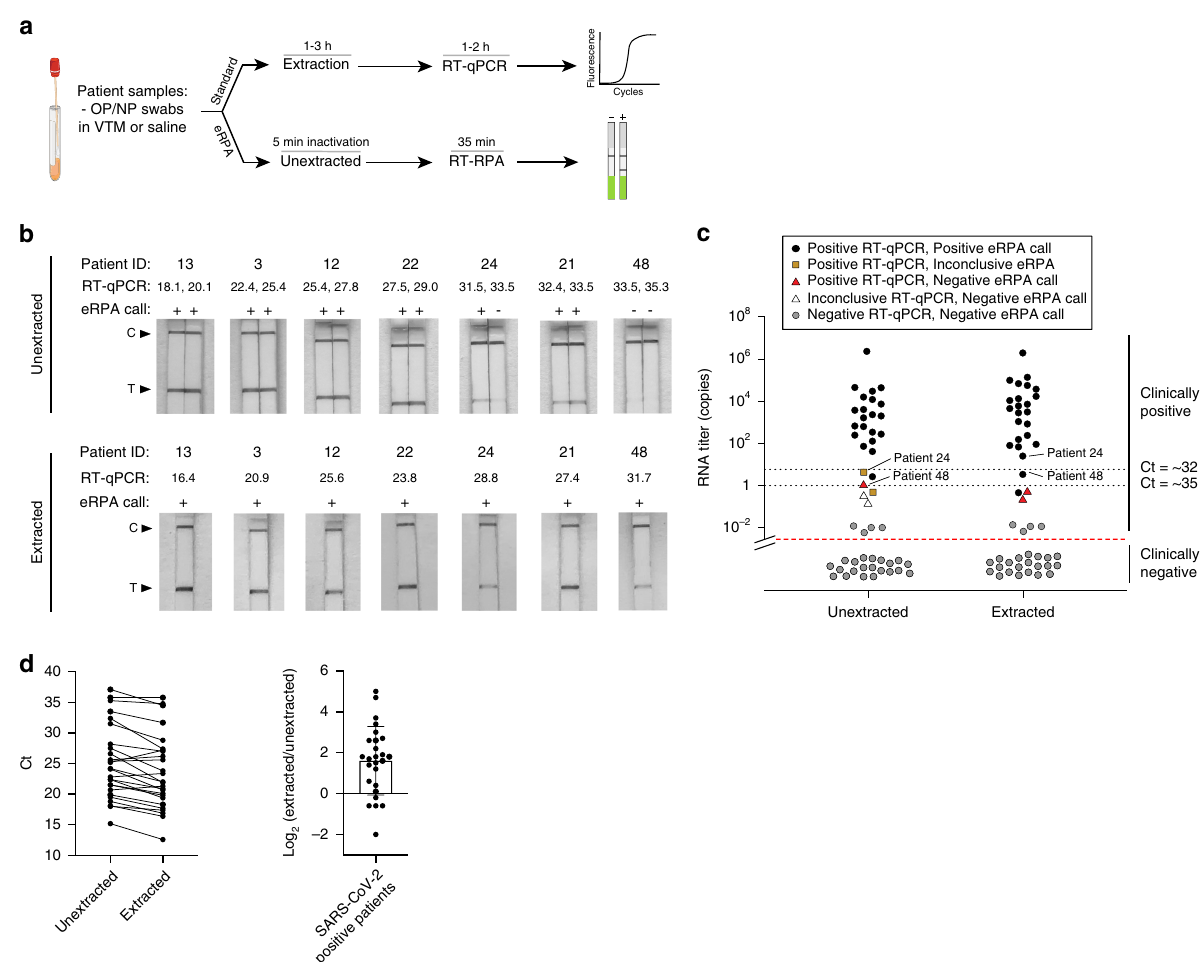
Fig. 4 Detection of SARS-CoV-2 in clinical samples using eRPA. a Schematic of the work fl ow for benchmarking eRPA against RT-qPCR using patient samples. b Sampling of lateral fl ow strip readouts of SARS-CoV-2 N gene eRPA tests of unextracted (top) or extracted (bottom) patient samples ( n = 7 biologically independent samples) of known infection status. Unextracted patient samples were run in duplicates both by eRPA (calls of positive ( + ) or negative ( − ) were made within 20 min of detection) and by one-step RT-qPCR (Ct values shown). See additional data in Supplementary Fig. 4a. RNA was extracted from clinical samples according to standard procedure (see “ Methods ” section) and was subsequently used as input to eRPA and RT-qPCR. See additional data in Supplementary Fig. 4b. c Summary of eRPA test results of patient samples ( n = 51 biologically independent samples) and comparison to RT-qPCR. The y axis represents patient viral titer determined using a commercial one-step RT-qPCR assay from unextracted samples or extracted RNA samples with a standard curve. d (Left) Matched RT-qPCR Ct values of unextracted and extracted patient samples ( n = 26 biologically independent samples) (Right) Difference between extracted and unextracted Ct values for all patients ( n = 26 biologically independent samples) with mean value of 1.6 fold + / − 1.7 SD. Source data are available in the Source Data fi